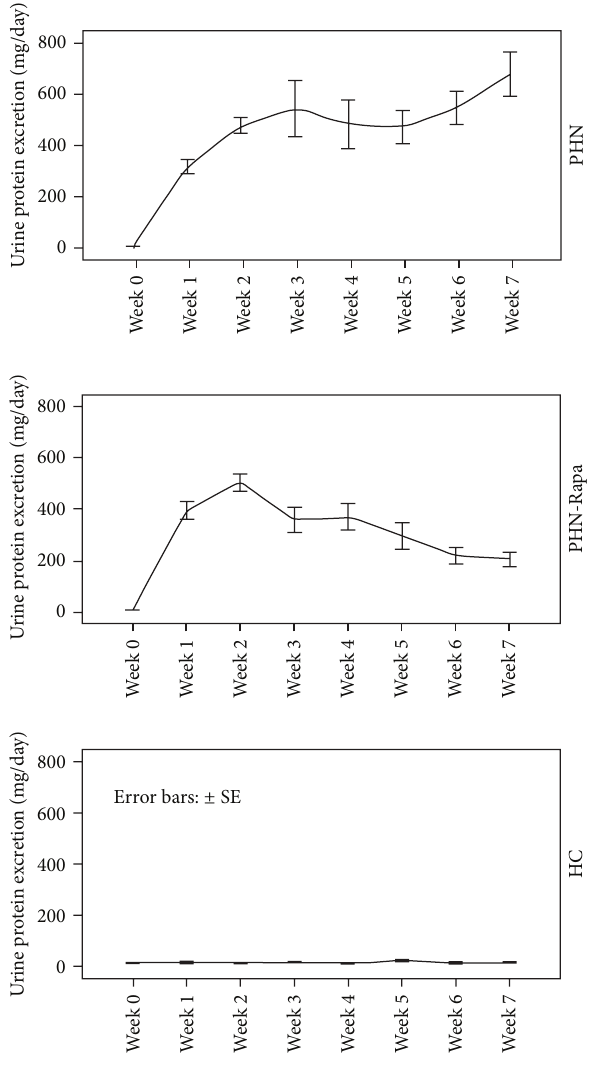
Figure 1: 24-hour urine protein excretion in study groups. Rapamy- cin was administered at week one in the PHN-Rapa group resulting in gradual amelioration of proteinuria in contrast to the PHN group in which proteinuria continued